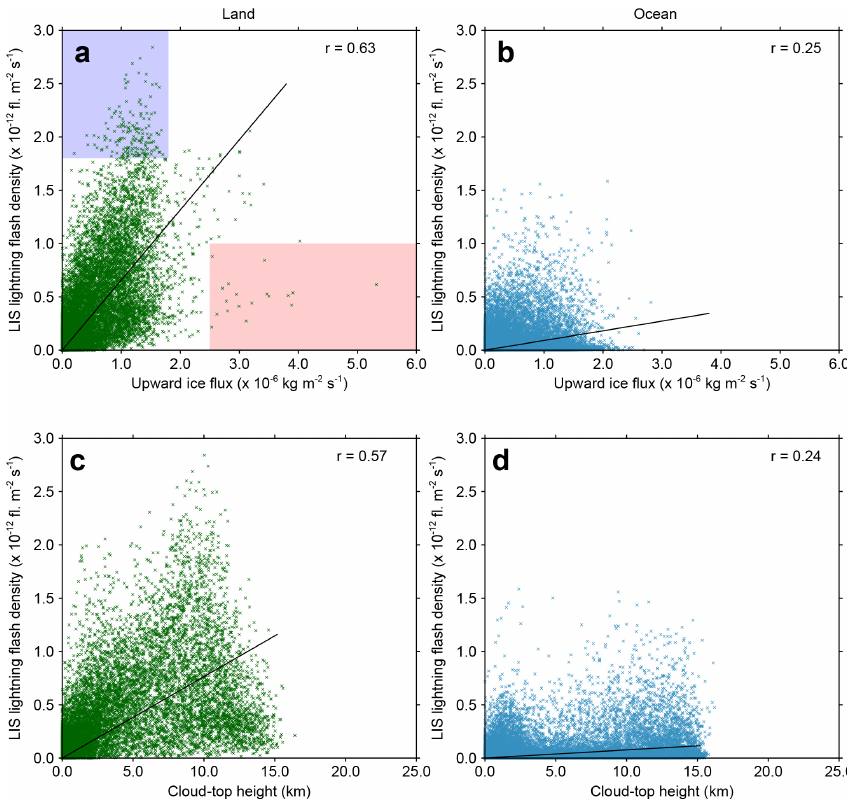
Figure 2. Scatter plots of upward ice flux at 440hPa formed from ERA-Interim reanalysis against LIS flash density. Shown in (a) are land grid cells and (b) are ocean grid cells. Also shown is the cloud-top height formed from ERA-Interim reanalysis against LIS flash density over (c) land and (d) ocean. Each point represents the monthly average of each variable for a grid cell in the range ± 38 ◦ latitude. The scatter points highlighted in (a) are used in Fig. 3 for studying under-estimation (light blue) and over-estimation (light red) of this regression. All scatter points, even within the highlighted regions, were used to create the linear